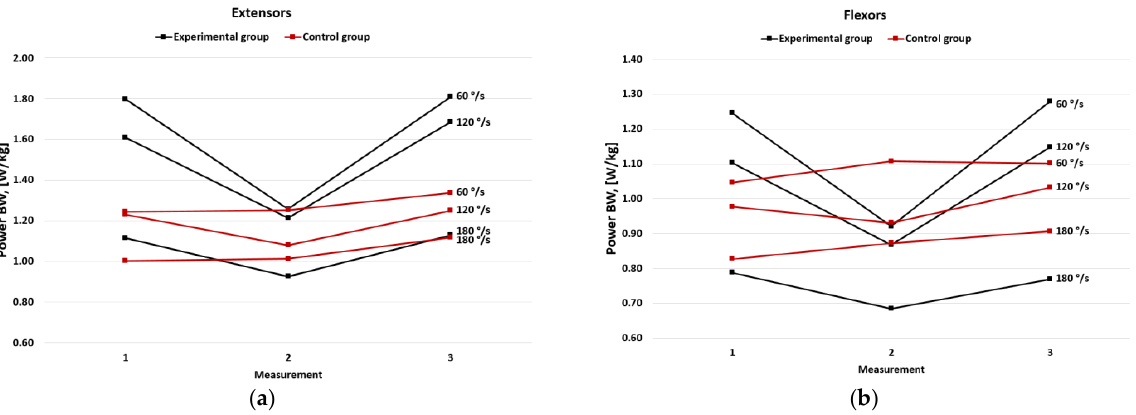
Figure 3. Mean of work per repetition per body weight in the experimental and the control group for ( a ) extensors and ( b ) flexors.